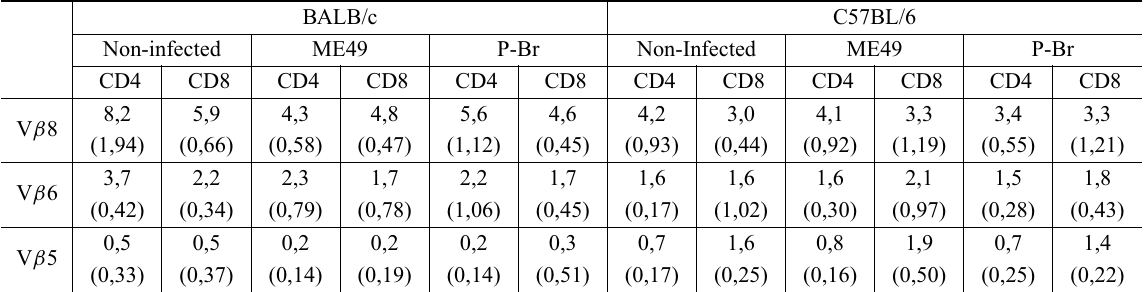
Analysis of the frequency of different TCR V β chains in T cells from mice infected with P-Br or ME49 strains of T. gondii .